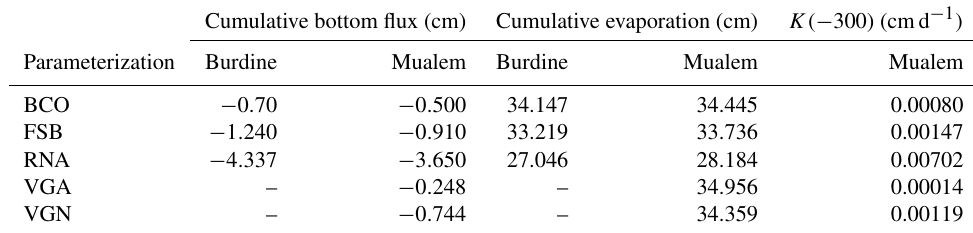
Figure 7. Cumulative infiltration in a silt profile for the VGA parameterization (see Table 1) with conductivity functions according to Mualem (1976) and Alexander and Skaggs (1986) (a) and four different parameterizations for the retention curve (see Table 1) with the Alexander and Skaggs conductivity function (b) . Table 3. Cumulative bottom and evaporative fluxes (positive upwards) for silt from day 281 (the start of the first rainfall) onwards for Burdine and Mualem conductivity functions with the different parameterizations. The hydraulic conductivity at h =− 300cm (the initial condition at the bottom) is also